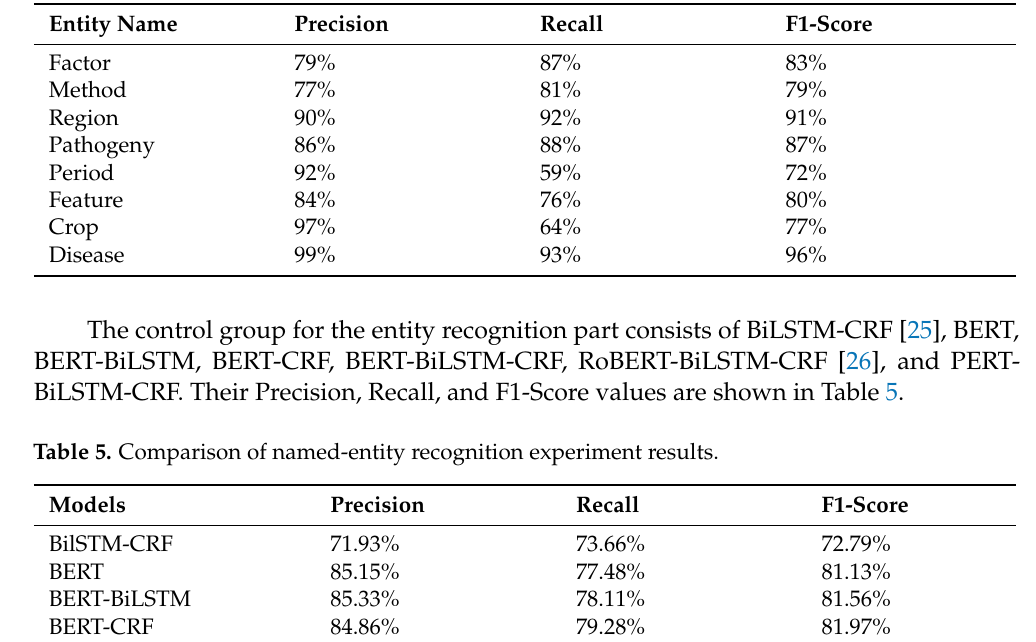
Table 4. Entity recognition results.